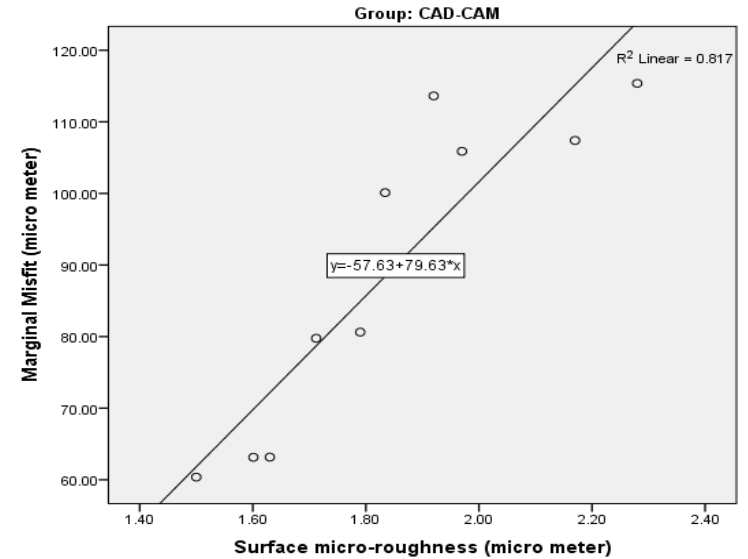
Figure 4. Showing a positive correlation between surface micro roughness and marginal misfit in CAD-CAM samples. R 2 showed 81.7% variation in marginal misfit explained by surface micro roughness; p -value was less than 0.01, and therefore statistically significant.